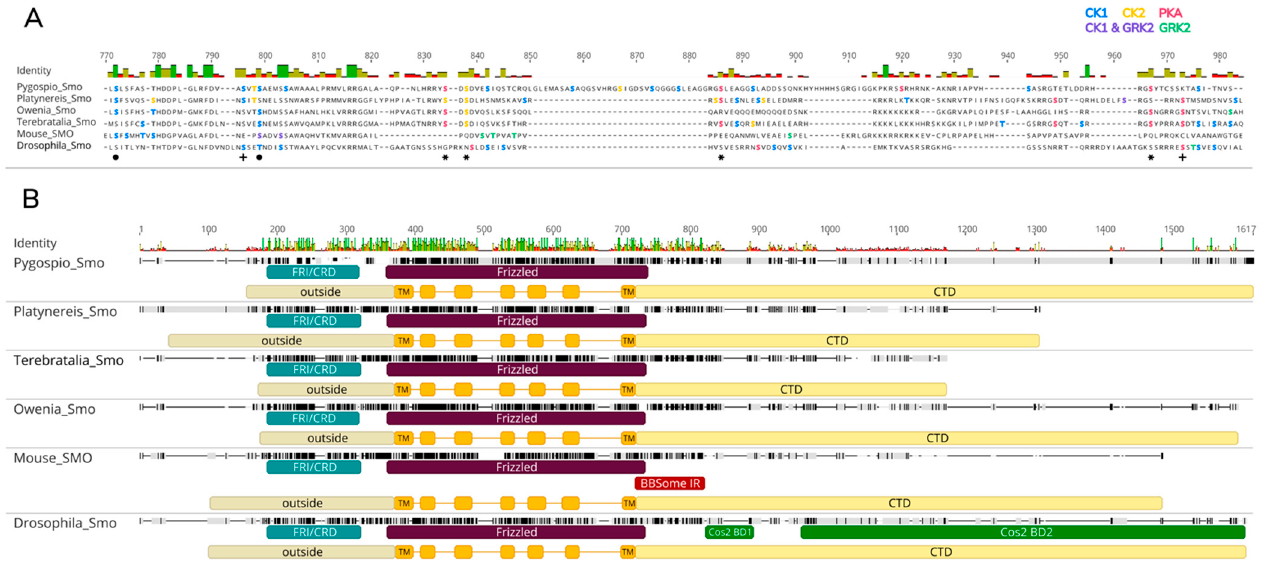
Figure 6. Analysis of Smo phosphorylation sites and domain composition. ( A ) Alignment of PKA, CK1, CK2, and GRK2 phosphorylation sites in Smo proteins. The prediction results suggest that Pele-Smo and Pdum-Smo C-terminal tails may be the phosphorylated substrates of PKA (red), CK1 (blue), CK2 (yellow), and GRK2 (green, common sites with CK1 in violet) kinases. Most phosphorylated residues predicted in annelids are not conserved in fruit fly and mouse. In the studied spiralians, there were three lineage-specific and conserved PKA phosphorylation sites and one CK2 phosphorylation site; these sites are marked with asterisks. Phosphorylation sites that overlapped between annelids and mouse are marked with dots, and sites that overlapped between annelids and fruit fly are marked with plus signs. ( B ) Multiple sequence alignment of Smo proteins. The cysteine-rich and Frizzled domains encompassing the heptahelical TM region were relatively conserved among spiralians, fly, and mammals (59–76% similarity). These parts of the annelids’ Smo proteins shared more identity with the murine protein (45–51% identity) than the fruit fly’s (45–51% identity). The CTD was the most divergent region of the protein (15–53% similarity). FRI/CRD, cysteine-rich domain; TM, transmembrane domain; CTD, C-terminal domain; BBSome IR, the BBSome interacting region; Cos2 BD1, Cos2-binding domain between amino acids 652 and 686; Cos2 BD2, Cos2-binding domain between amino acids 730 and 1035.